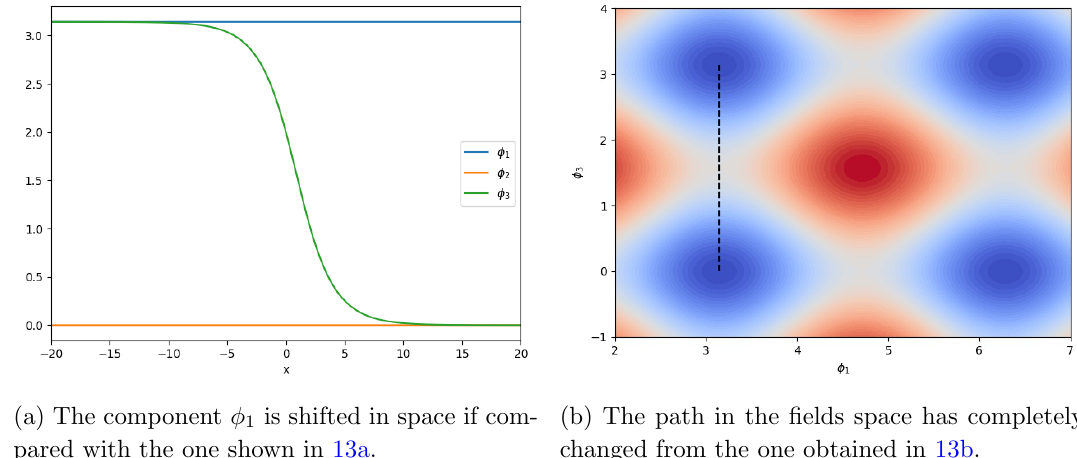
Figure 15. A BPS solution of the su (4) FKZ model for the particular case where (cid:30) 2 =